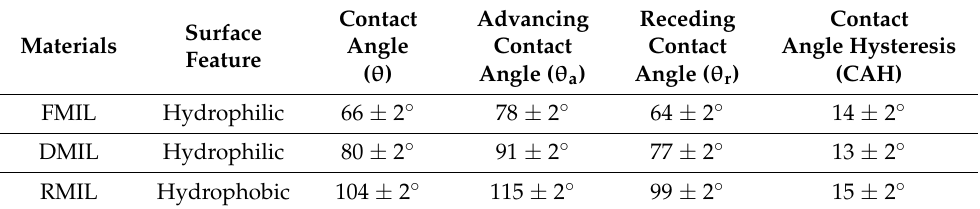
Figure 4. Contact angle (CA) of functional surfaces with a sessile droplet on; ( a ) Fresh Mangifera Indica leaf (FMIL) ( b ) Dry Mangifera Indica leaf (DMIL), and ( c ) Replicated Mangifera Indica leaf (RMIL). Table 1. Surface wettability.